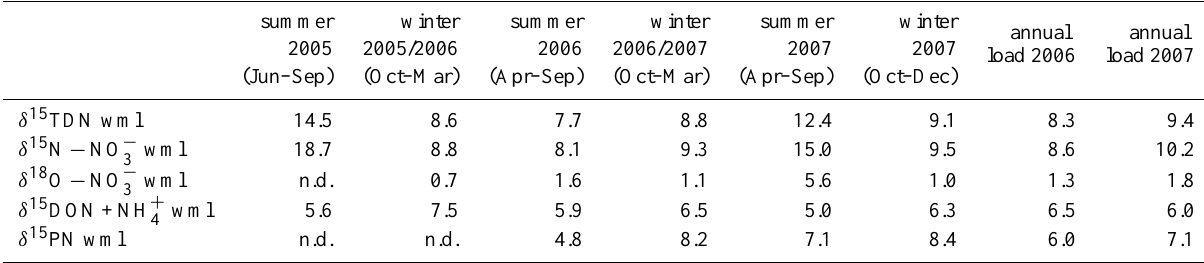
Table 4. Load weighted annual and seasonal mean isotope values of nitrate, TDN, DON+NH + Geesthacht, June 2005–December 2007 (n.d.=not